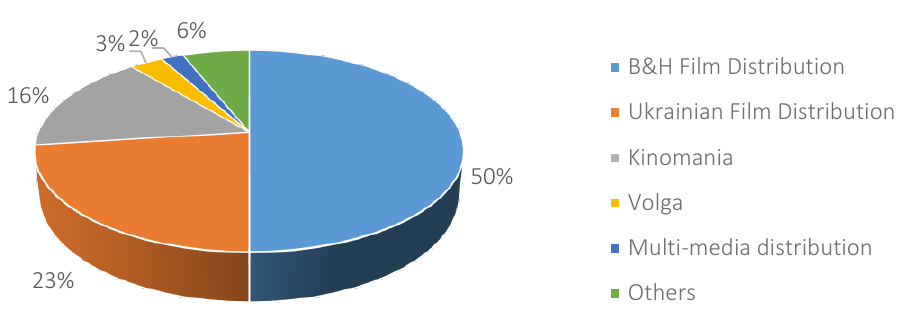
Figure 2. Distribution of film distribution market shares among film distributors in Ukraine, %